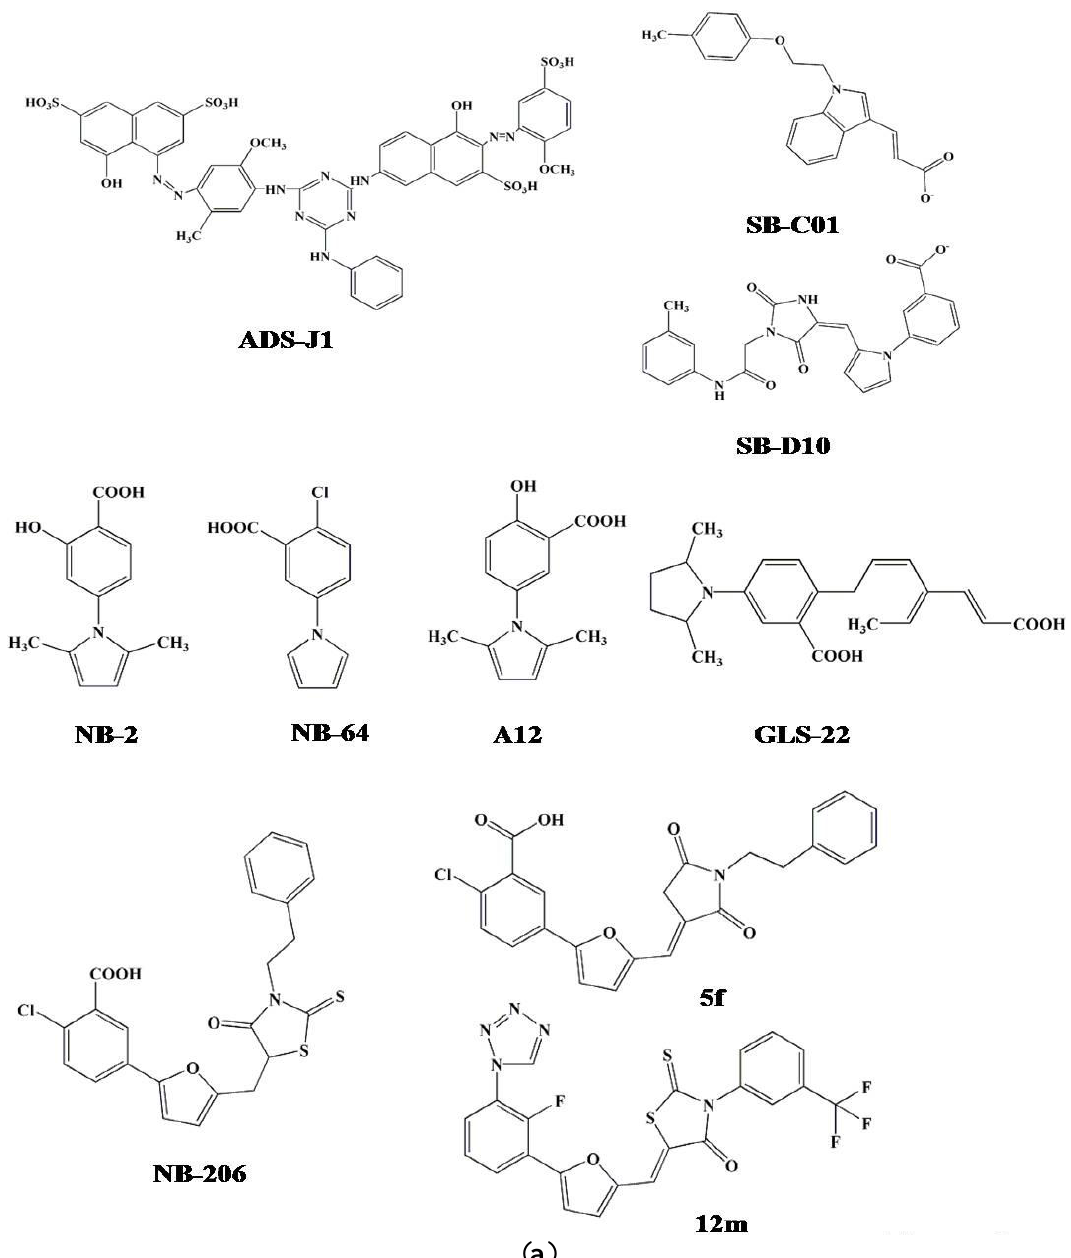
Figure 3. The chemical structures of the small molecule HIV-1 entry inhibitors targeting the gp41